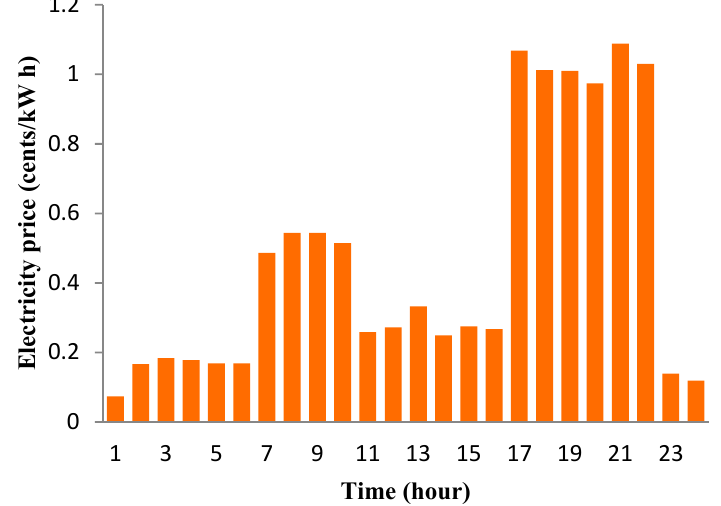
Figure 8. Predicted average electricity prices of a house over a 24 h horizon.